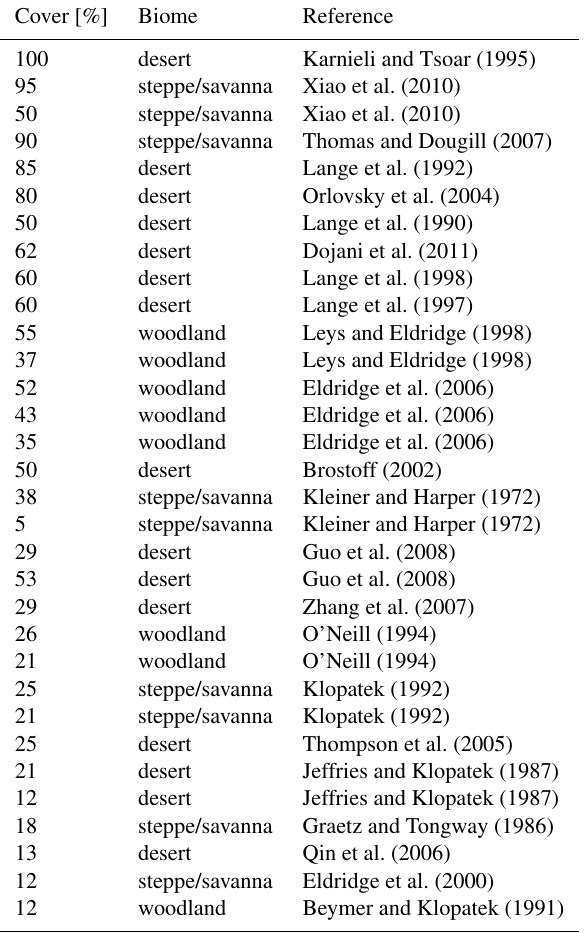
Table A1. Studies reporting values of total biocrust cover which are used in the model–data comparison (Fig.